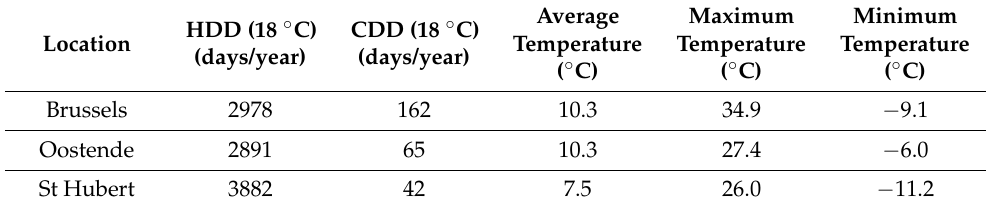
Table 9. Summary of weather conditions for three cities representative of different climates in Belgium.